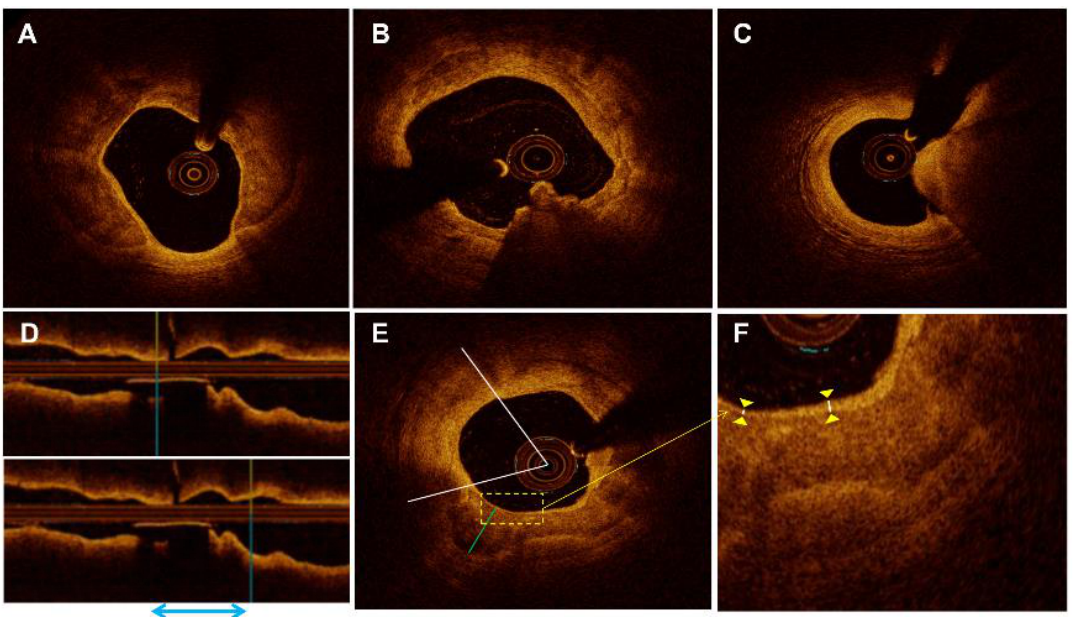
Figure 2. Representative optical coherence tomography images. ( A ) Superficial calcific sheet; ( B ) eruptive calcified nodules; ( C ) calcified protrusion; ( D , E ) measurement indicators of calcification. ( D ) The distance between the blue double arrows shows the length of calcification. ( E ) The green line represents the thickness of calcification. The white lines represent the angle of calcification. The yellow box represents the depth of calcification. ( F ) The yellow triangles represent the enlarged image of the depth.